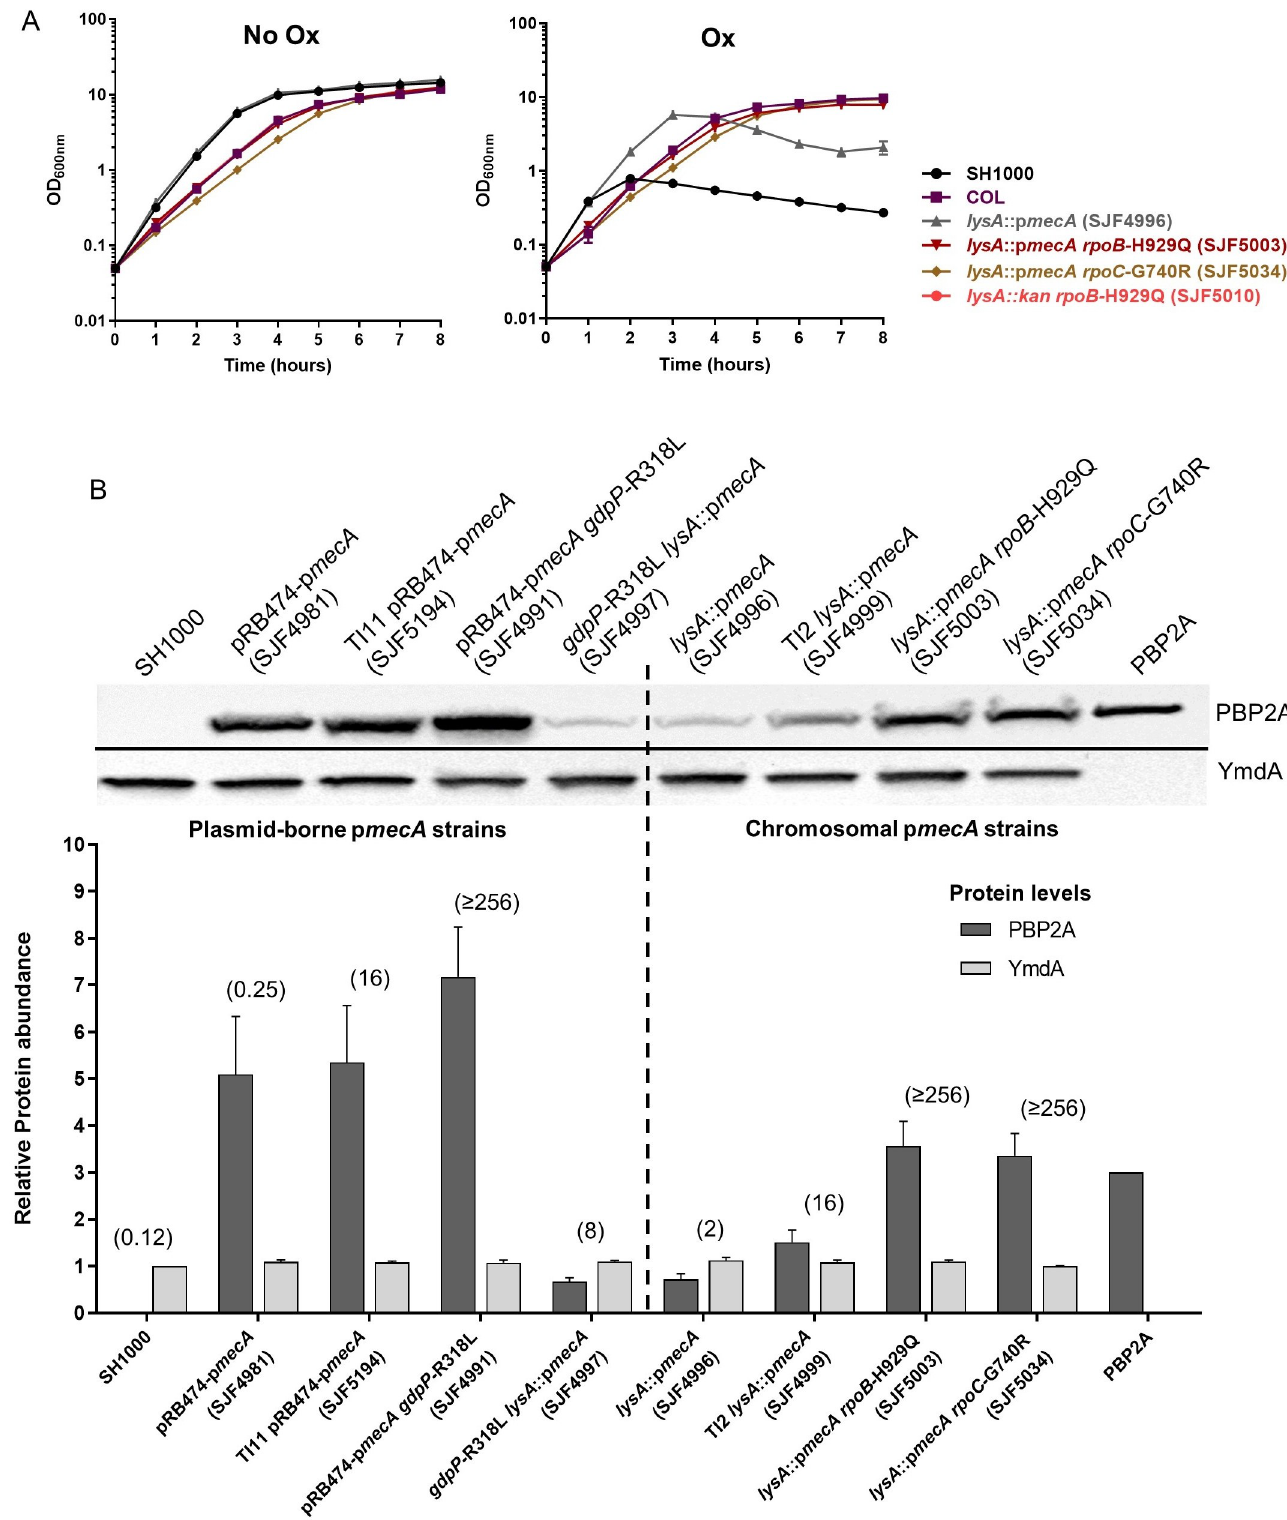
Fig 4. Growth characteristics and PBP2A production of S . aureus strains. A) Growth of representative strains, lysA ::p mecA rpoB- H929Q (SJF5003), lysA :: kan rpoB- H929Q (SJF5010), lysA ::p mecA rpoC- G740R (SJF5034) were compared to the SH1000, COL and lysA ::p mecA (SJF4996) in the absence (left) and presence